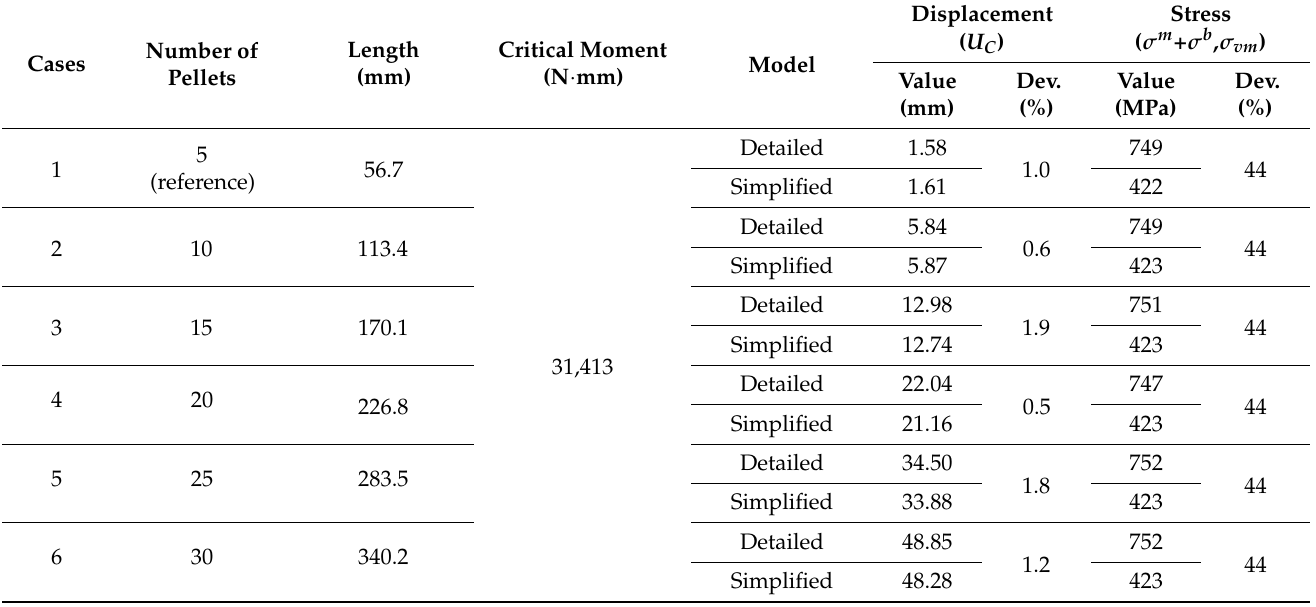
Table 5. Application of the simplified model parameters for the bonded condition to different lengths of fuel rod segments.